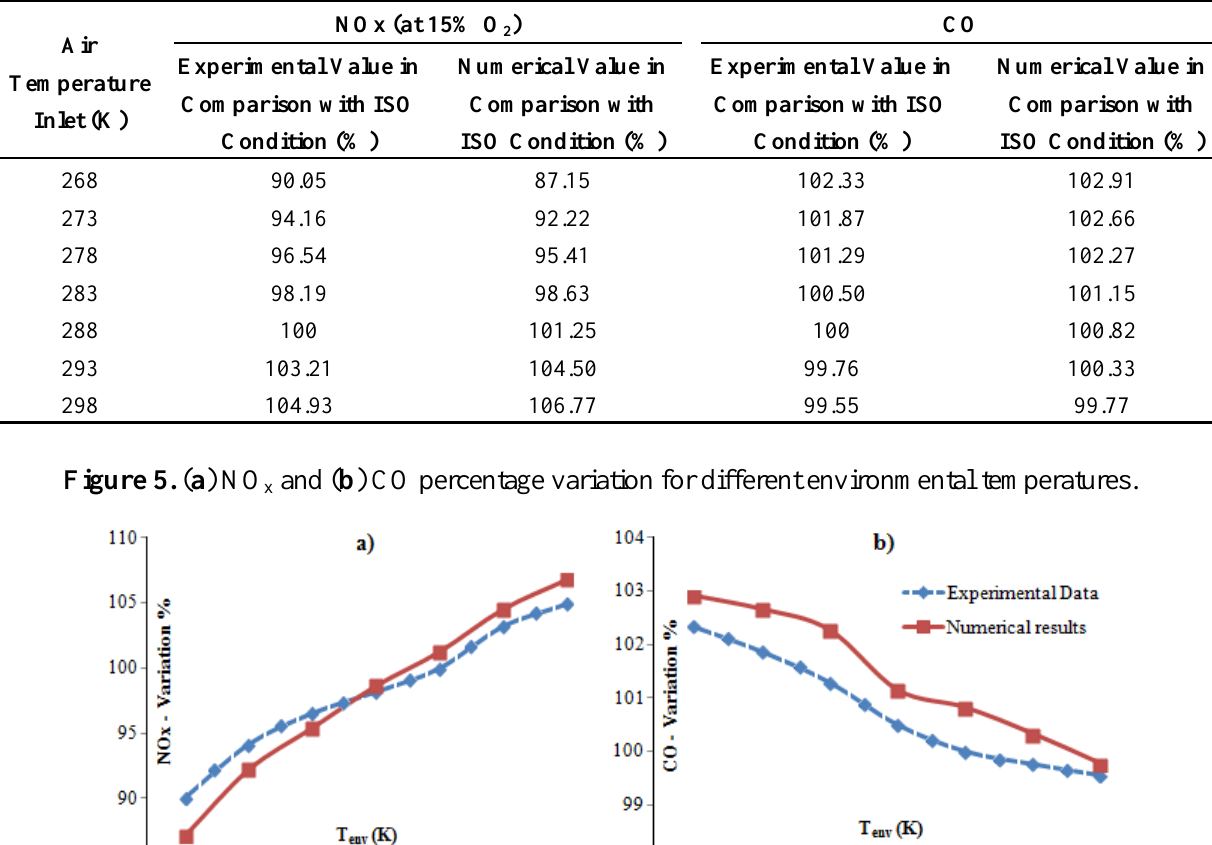
Table 7. The effect of the air temperature at the compressor inlet on pollutant emissions.